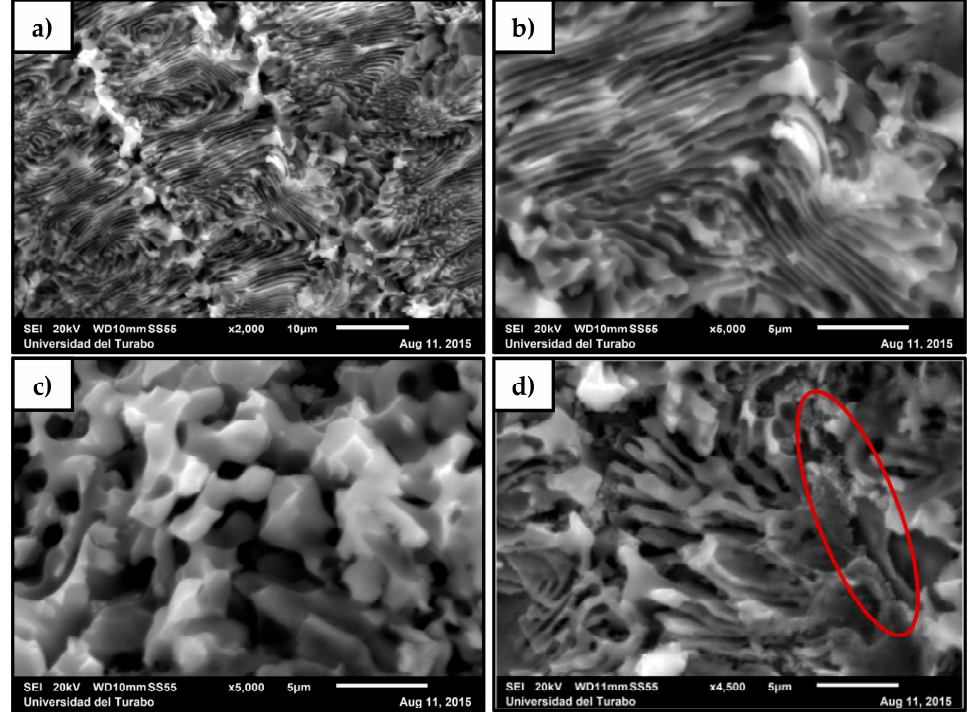
Figure 6. SEM images of: ( a ) Al-Cu eutectic directionally solidified and corroded in 10 vol. % NaOH aqueous solution for 4 h; ( b ) Al-Cu eutectic colony in a directionally solidified specimen corroded in 10 vol. % NaOH aqueous solution for 4 h; ( c ) the perimeter of Al-Cu eutectic colony in a directionally solidified specimen corroded in 10 vol. % NaOH aqueous solution for 4 h; and ( d ) ligament detachment in a eutectic Al-Cu specimen directionally solidified and corroded.